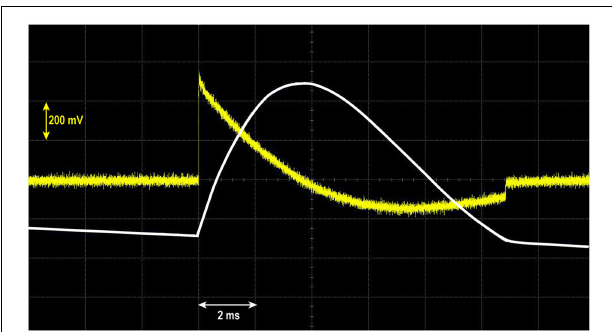
FIGURE 2 | Snapshot of the digital oscilloscope displaying an output curve from the field-sensing coil (yellow), along with its integration with respect to time (white). The intensity of the maximum peak field is equivalent to 0.7 T. A slightly negative baseline trend of the integrated field is due to a small dc offset ( < 1 μ V) of the oscilloscope.